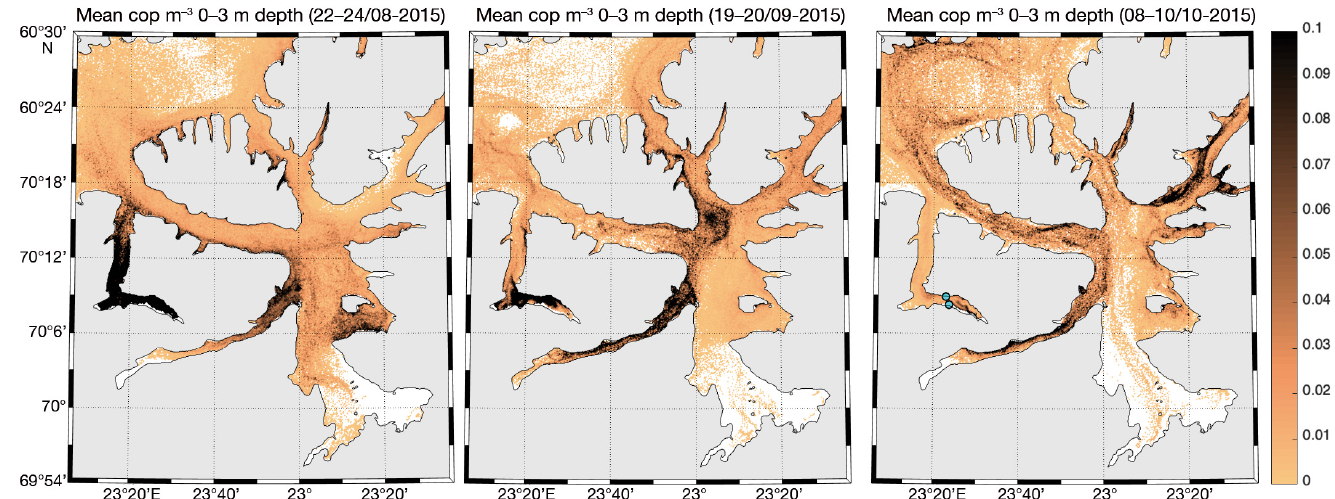
Fig. 5. Modelled abundance of salmon lice copepodids in Altafjorden during the 3 cruise periods. Figures show the mean con- centrations (ind. m −3 ) of lice copepodids (cop) per grid cell (area 160 × 160 m 2 ) at 0 to 3 m depth over 3 periods corresponding to each of the cruise periods. Blue dots in the right panel mark the positions for the time series shown in Fig.